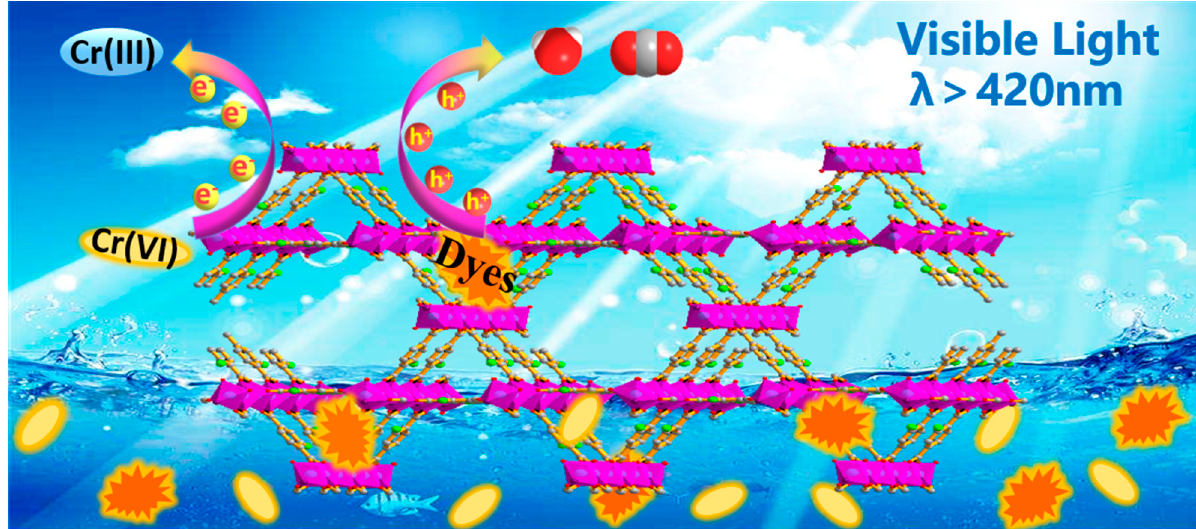
Figure 8. The schematic illustration of photocatalytic removal of Cr(VI) and RhB over MIL- 68(Ga)_NH 2 under visible light irradiation.